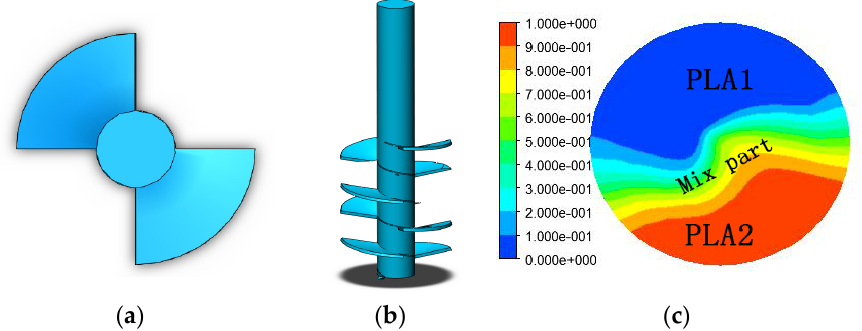
Figure 6. The disconnected spiral blade stirring shaft ( a ), the corresponding simulation ( b ), and the exit section phase distribution ( c